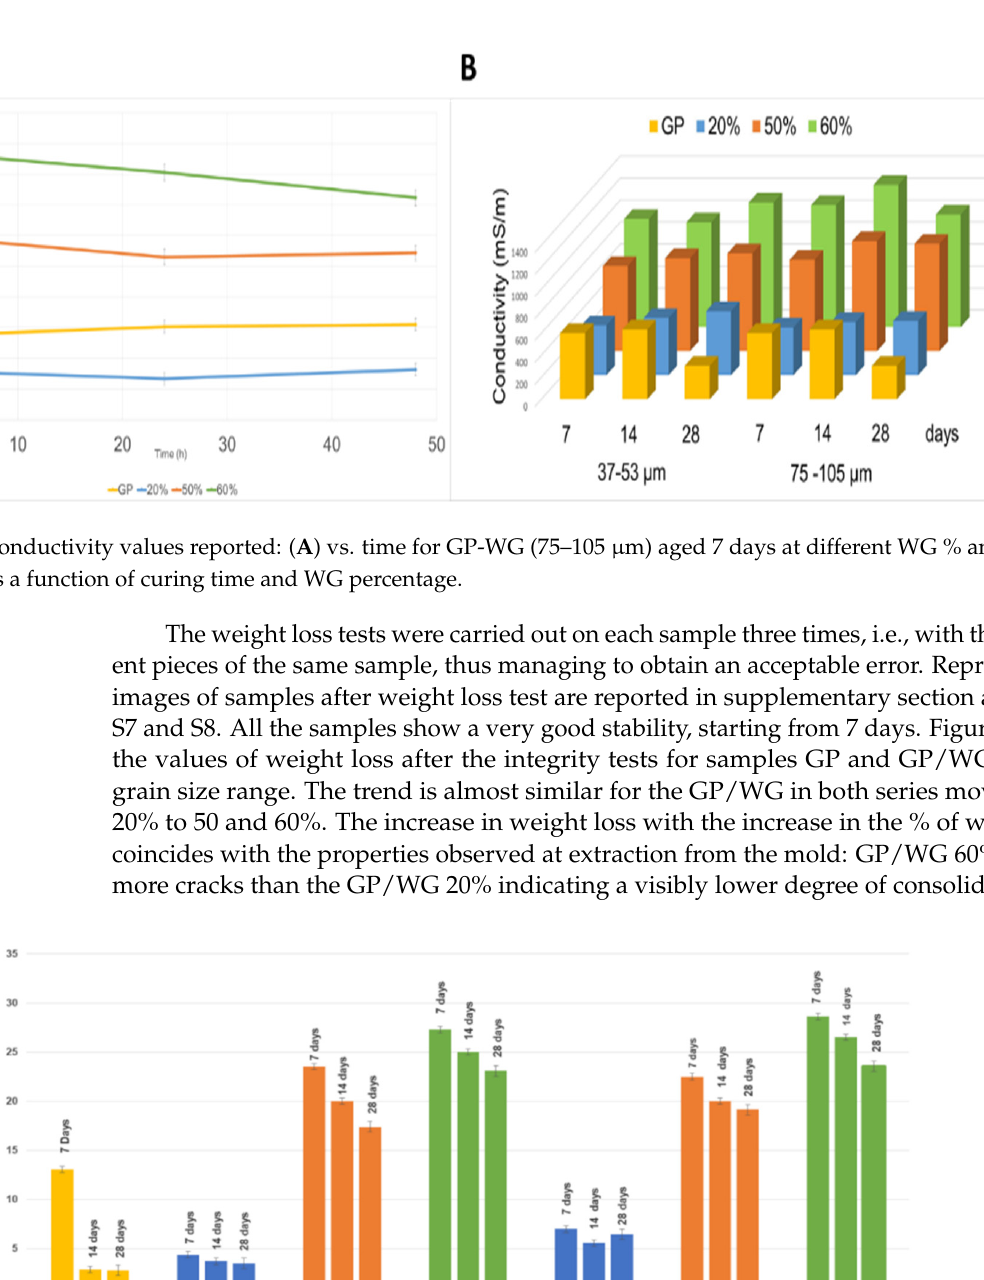
Figure 3. Values of weight loss after the integrity tests for samples GP and GP/WG from 37–53 μ m and 75–105 μ m series.